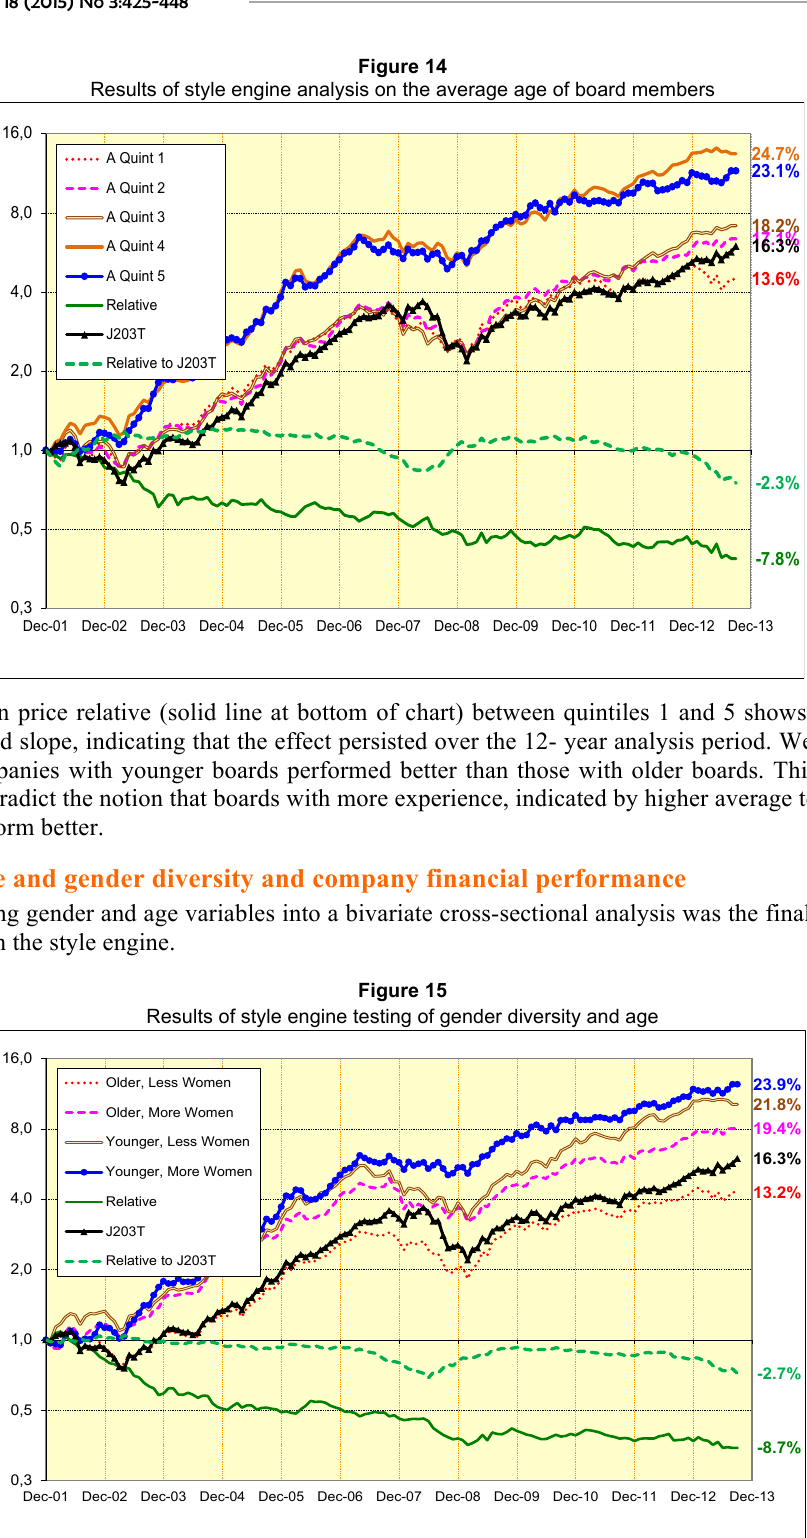
Figure 14 Results of style engine analysis on the average age of board members